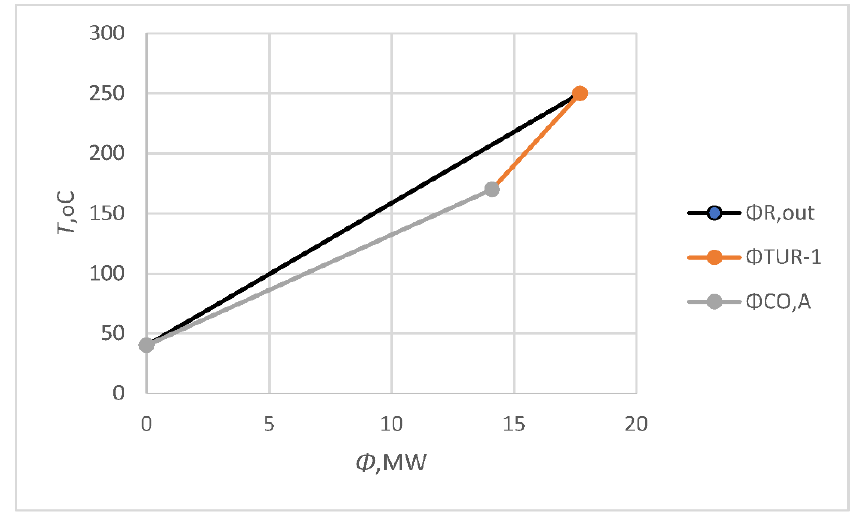
Figure 3. The usage of electricity cogeneration with one gas turbine, including cooling.